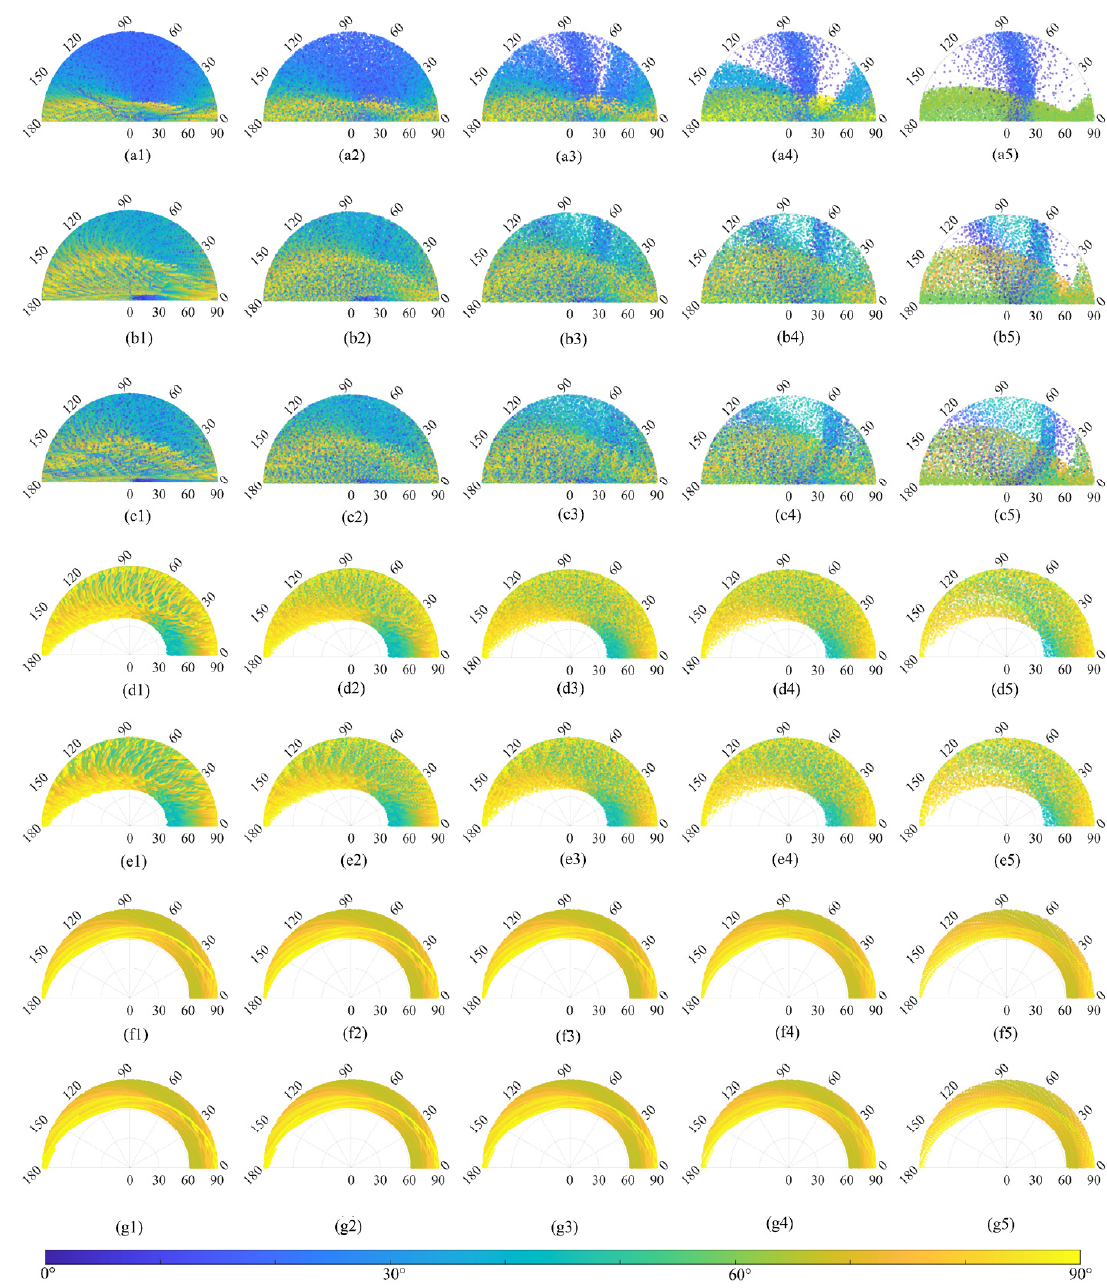
Figure 6. Angular combination distribution of different points at different time sampling intervals. ( a1 – a5 ) Point D; ( b1 – b5 ) Point C; ( c1 – c5 ) Point E; ( d1 – d5 ) Point B; ( e1 – e5 ) Point F; ( f1 – f5 ) Point A; ( g1 – g5 ) Point G; ( a1 – g1 ) 10 min; ( a2 – g2 ) 30 min; ( a3 – g3 ) 1 h; ( a4 – g4 ) 2 h; ( a5 – g5 ) 4 h. (The polar axis represents the relative azimuth angle, polar diameter represents the viewing zenith angle, and color represents the solar zenith angle).